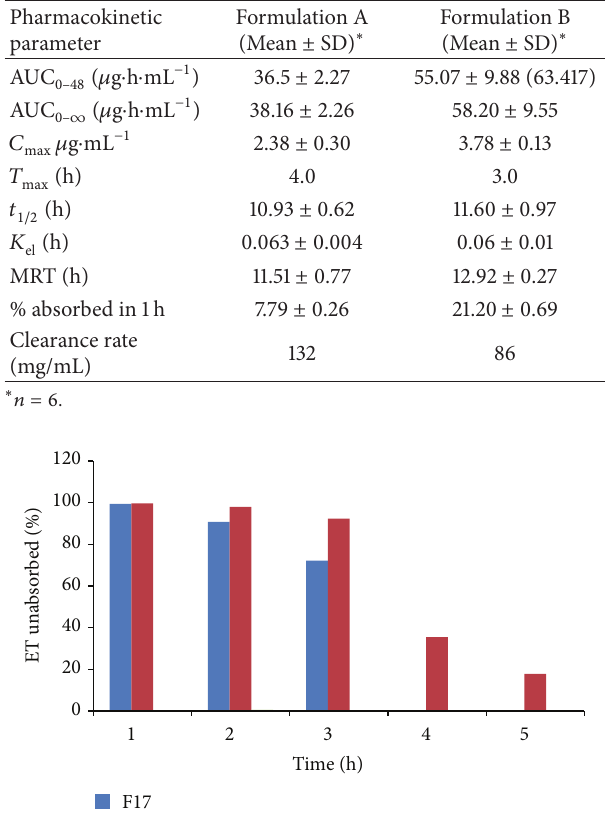
Table 4: Pharmacokinetic parameters after oral administration of ET formulations.